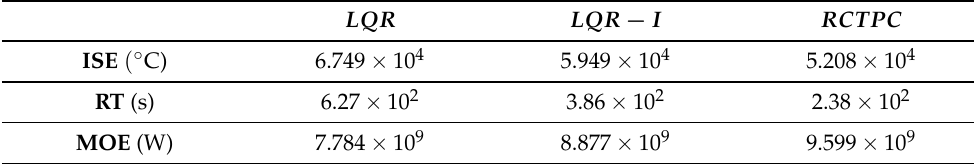
Table 2. The results of the quality criteria for the two-level thermal object